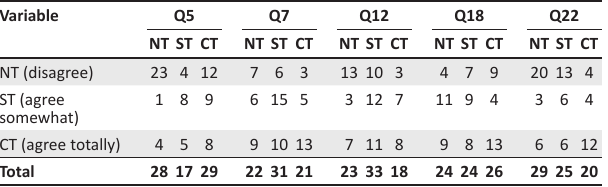
FIGURE 1: Comparison of the mean scores per question of the Strengths and Disabilities Questionnaire completed by adolescent–caregiver pairs; adolescents were receiving treatment at the Weskoppies Child and Adolescent Unit outpatient department (2017). TABLE 4a: Comparison of emotional symptoms domain scores for adolescent– caregiver pairs.